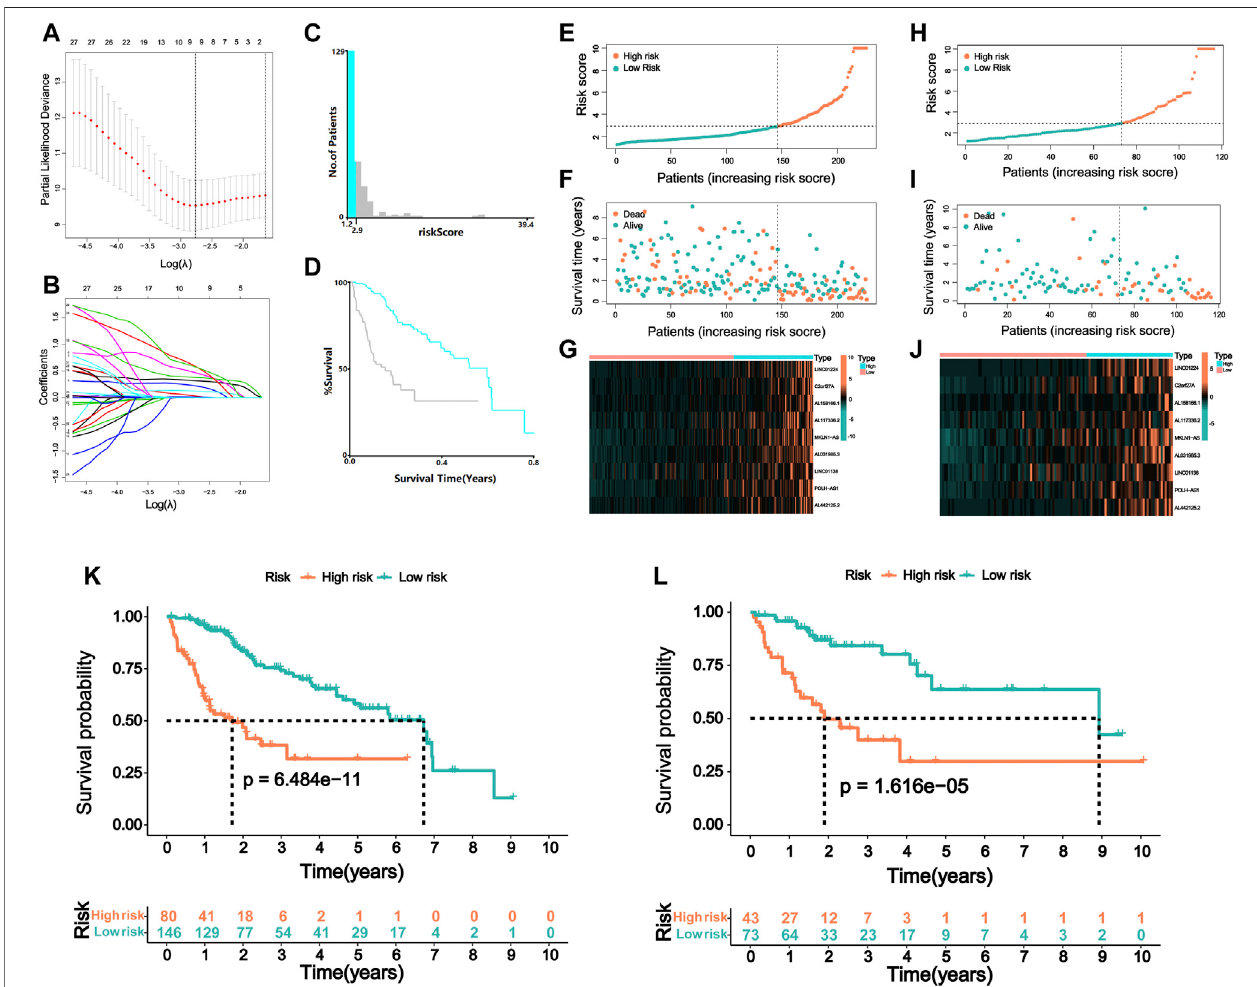
FIGURE4| Riskmodelofm6Aregulator-relatedlncRNA. (A) LassoCoxregressionanalysisof31 m6Aregulator-relatedprognosticlncRNAs. (B) Partiallikelihood deviation for different number of variables. (C) The optimal cutoff value of risk score identi fi ed by X-tile analysis. (D) Kaplan – Meier curve of HCC patients with the best cutoffvalueinX-tileanalysis.ThepictureisgeneratedbyX-tilesoftware. (E) Thedistributionofriskscoresand (F) survivalstatusofHCCpatientsinthetrainingcohort. (G) The expression matrix ofninelncRNAsincluded inthe model inthetraining cohort ofHCC patients. (H) Thedistributionofriskscores and (I) survivalstatus ofHCC patients in the validation cohort. (J) The expression matrix of nine lncRNAs included in the model in the validation cohort of HCC patients. Kaplan – Meier curve of OS of high-risk and low-risk HCC patients in the (K) training and (L) validation cohort.